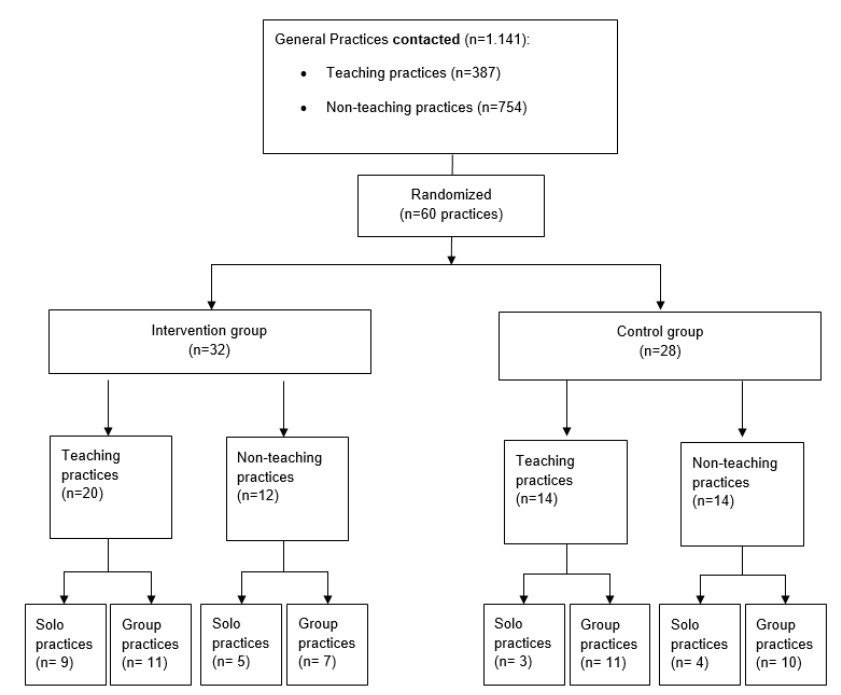
Figure 2. Recruitment flow